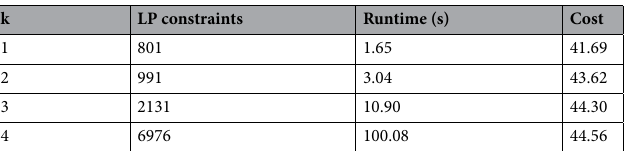
0 ) (leading to infection of the entire city, if not 0 ) , optimal